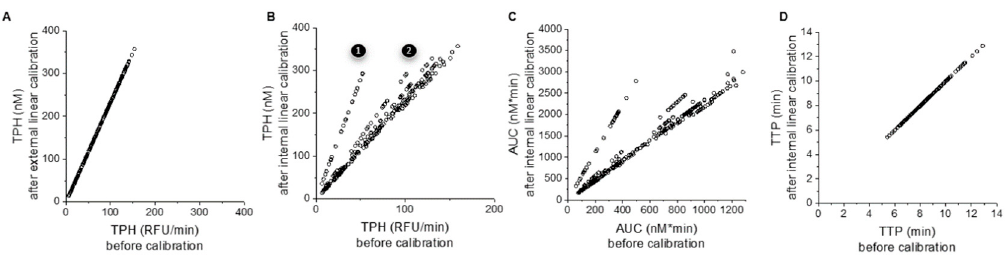
Figure 3. Effect of internal calibration algorithms on TG parameter values in PFP supplemented with coagulation factors and/or TM. Each dot represents a single experimental condition (e.g., NPP + 100% FVIII + TM, averaged over 3 replicates). Experiments with added FII were excluded due to unusual behavior. The graphs show correlation between uncalibrated TG parameter values ( x -axis) and respective values after correction-calibration. ( A ) TPH before and after external linear calibration (TG curves multiplied by a calibration coefficient determined from all experimental runs). ( B ) TPH before and after internal linear calibration (where the calibration coefficient was calculated from internal calibrator wells in each experimental run). Comment: 1 and 2 denote experiments with low overall fluorescence, corrected by internal calibrator (calibrators shown in Supplementary Materials, Figure S3). ( C ) AUC before and after internal linear calibration. ( D ) TTP before and after internal linear calibration.